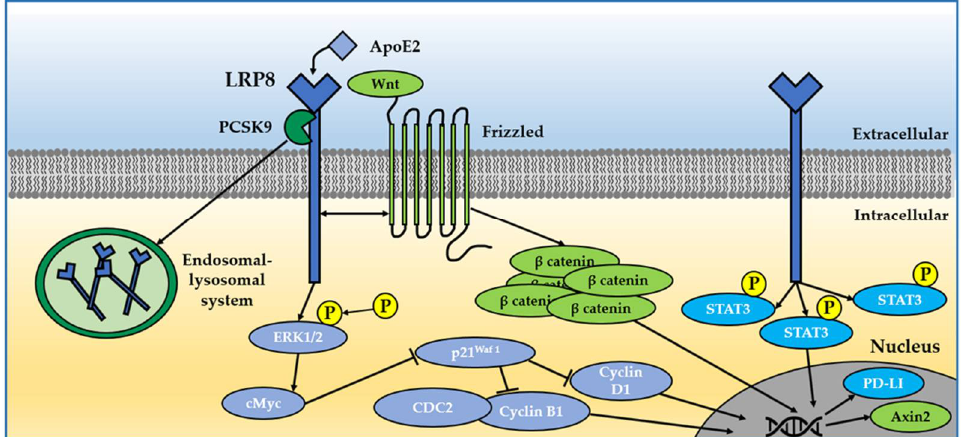
Figure 2. LRP8 in four main cancer-related molecular pathways. (1) LRP8 binding to ApoE2 induces ERK1/2 phosphorylation and cell cycle activation [150]. (2) LRP8 promotes Wnt-induced β-catenin accumulation, inducing Axin2 transcription [151]. (3) PCSK9 modulates LRP8 endocytosis and signaling by targeting the receptor for lysosomal degradation [152]. (4) LRP8 activates p-STAT3 and its nuclear signaling [141,153].